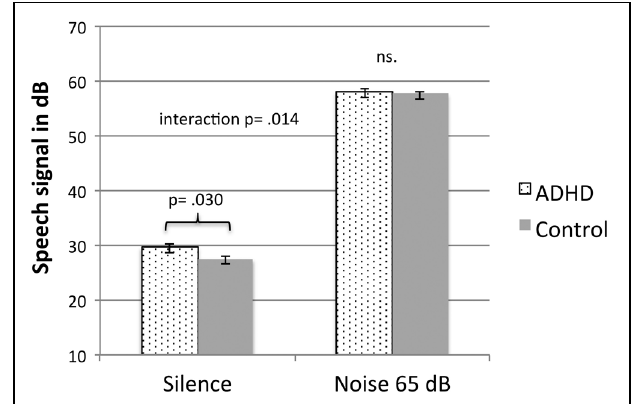
FIGURE 1 | Speech recognition thresholds for children with ADHD symptoms and TD children in a silence and in 65 dB modulated white noise. Error bars represent standard error of the